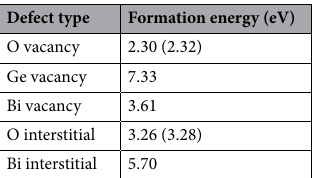
Table 2. Formation energies of intrinsic